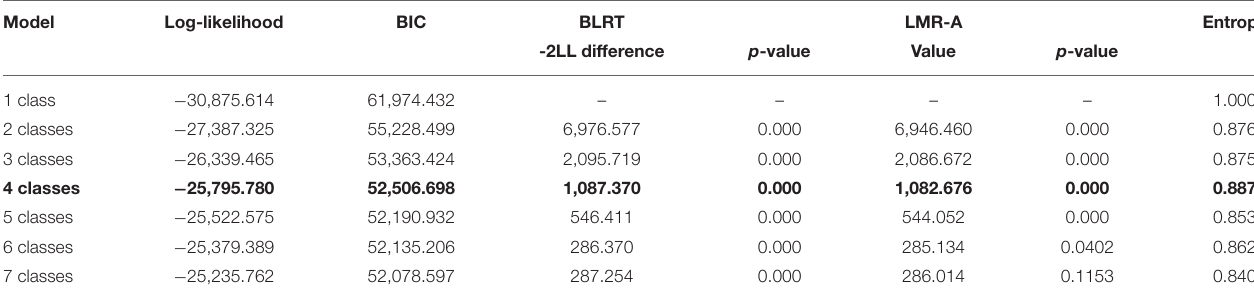
TABLE 3 | Model fitting results of the seven models with one- to seven-class solutions.